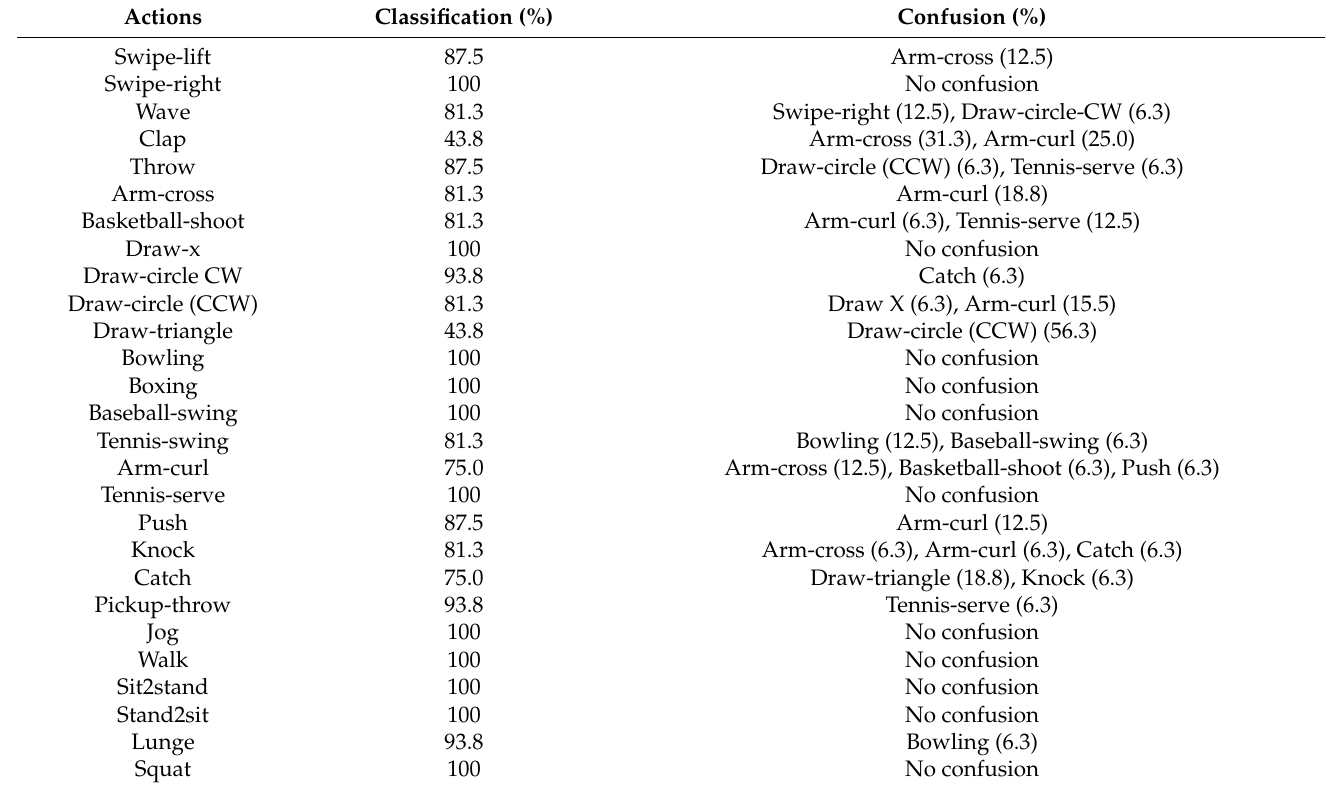
Table 6. Class-specific accuracy on UTD-MHAD